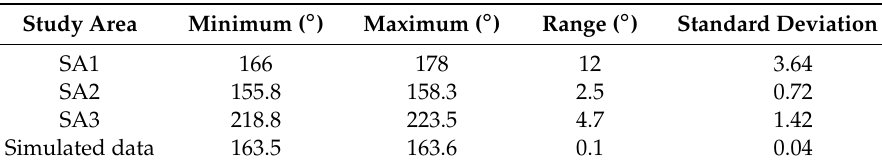
Table 7. Functional relationship between mean slope ( y ) and number of points in the neighbourhood ( x ) in study areas 1–3 and simulated data. Table 6. Descriptive statistics of mean aspect in study areas 1–3 and simulated data.